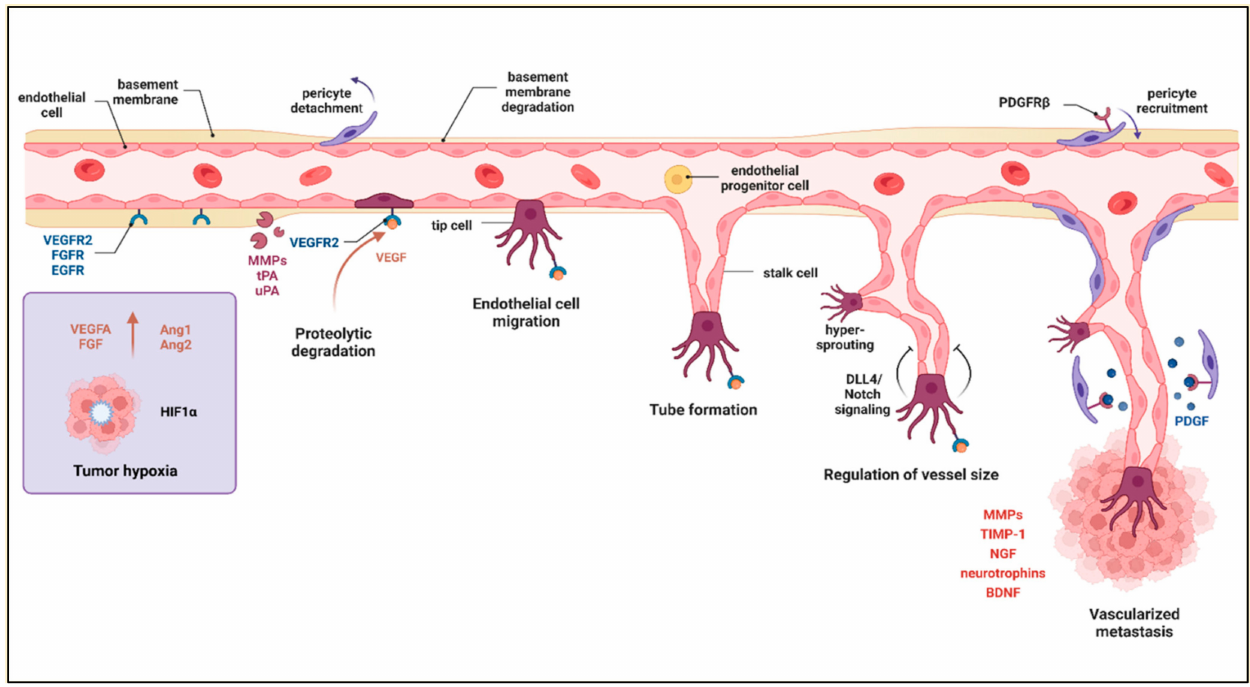
Figure 5. Tumor angiogenesis. To ensure the success of new blood vessel formation, a cascade of events usually occurs, including: hypoxia, proteolytic degradation, endothelial cell migration, tube formation, regulation of vessel size, and formation of tumor vasculature. Created with